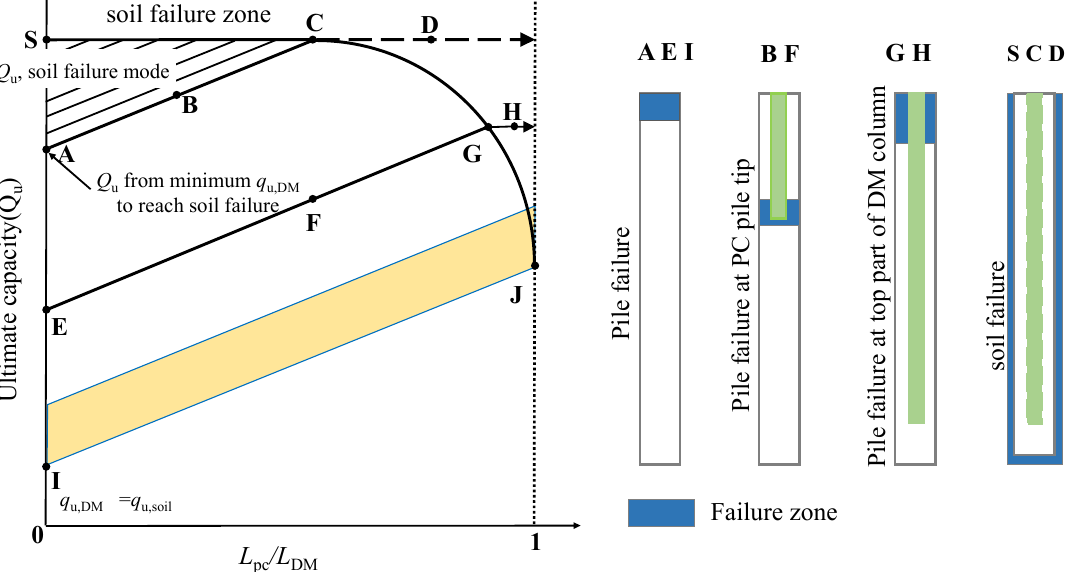
Figure 2. The relationship between the core length ratio and ultimate capacity, as well as the associated failure modes [48].